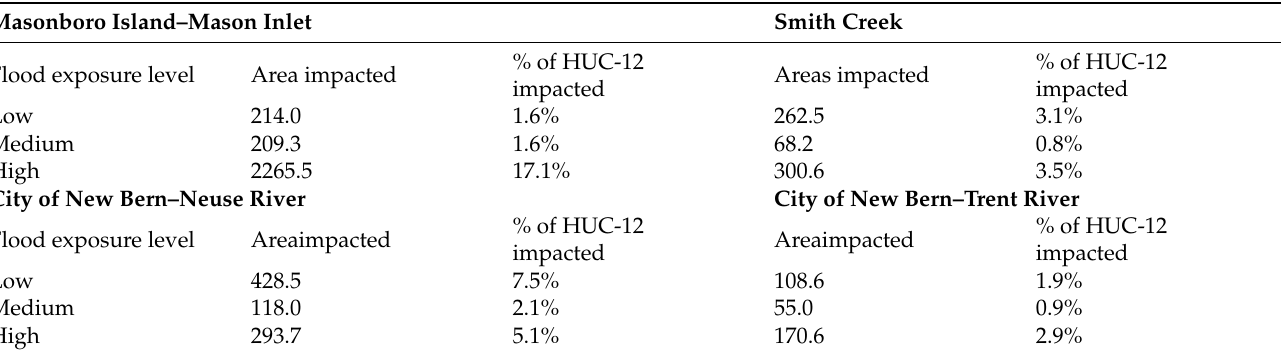
Figure 3. Flood exposure results of the Masonboro Island–Mason Inlet and Smith Creek subwater- sheds in New Hanover County, NC (left map) and City of New Bern–Neuse River and the City of New Bern–Trent River subwatersheds in New Hanover County, NC (right map). Table 2. Flood exposure risk for the four study areas as total area (acres) and a percentage of the HUC